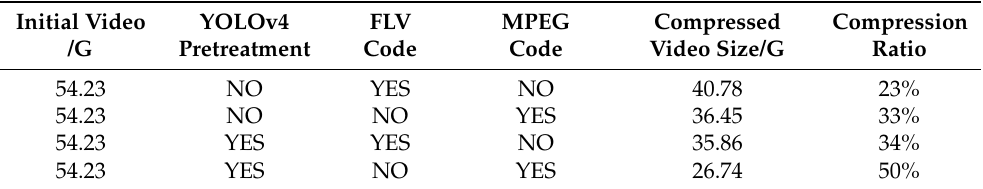
Table 5. Comparison Results of Compression Efficiency of Different Encoding Formats Based on YOLOv4.